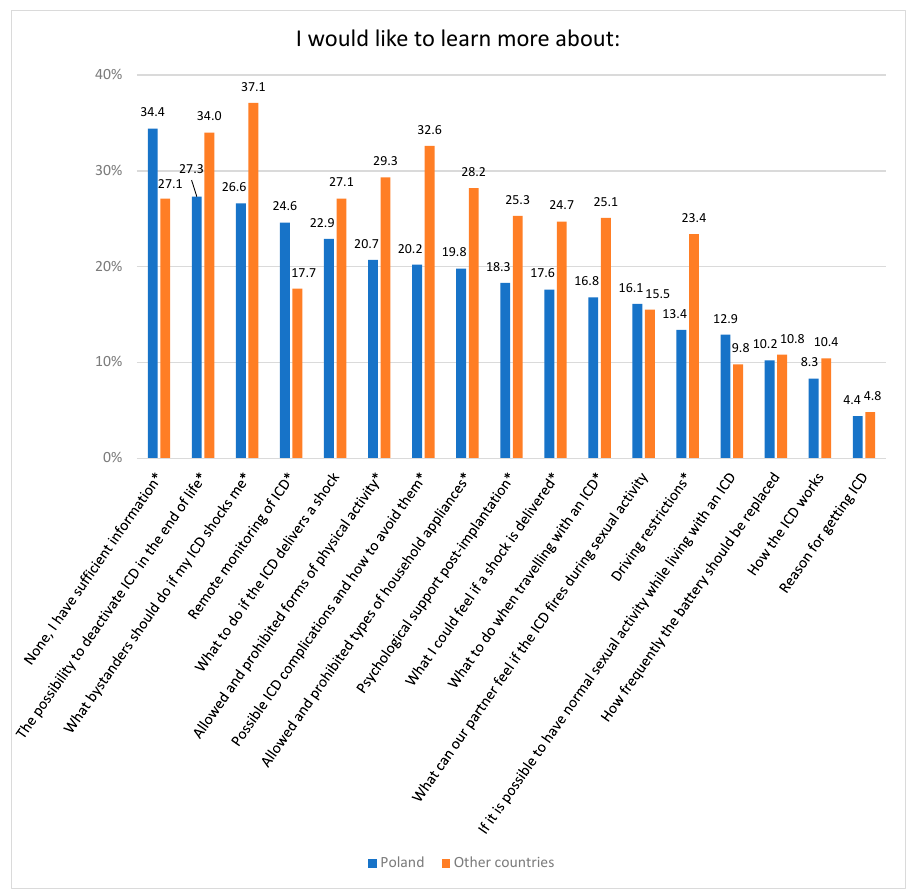
Figure 2. Patients’ needs regarding ICD education according to cohorts. * p < 0.05.